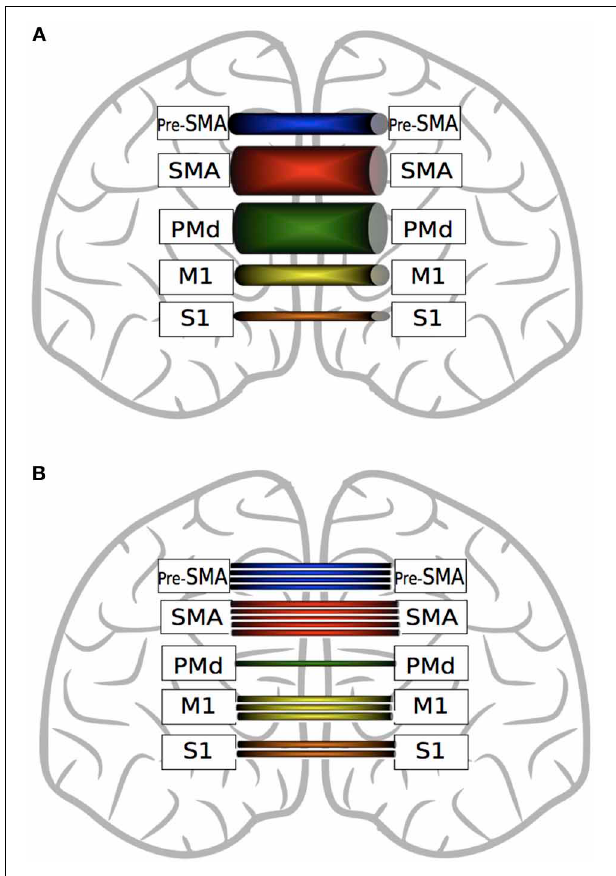
FIGURE 4 | A graphic depiction of the findings of Fling et al. (2011). Panel (A) represents fractional anisotropy (FA) of transcallosal fibers connecting homologous motor regions. Thicker tubes indicate higher FA values. SMA fibers exhibit greater FA values than pre-SMA, M1 and S1. Transcallosal PMd fiber FA values are greater than those connecting pre-SMA, M1 and S1. Fibers connecting homologousM1 and homologous pre-SMA exhibit higher FA values than S1 fibers. Panel (B) represents the quantity of interhemispheric fiber tracts connecting homologous motor regions. There are more fiber tracts connecting homologousSMA regions than M1, PMd and pre-SMA. There are more fibers connecting pre-SMA than M1, S1 or PMd. Transcallosal M1 fibers are more numerous than those connecting S1 or PMd. (See text for